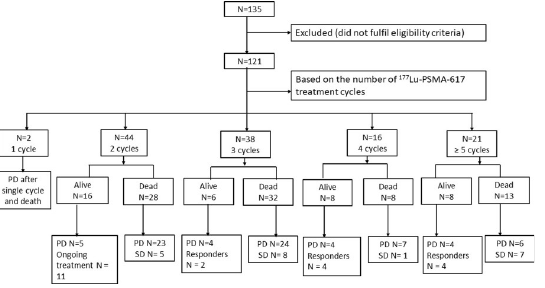
Fig 1. Flow chart depicting the course of treatment and the survival status of the patients categorized according to the number of 177 Lu-PSMA-617 RLT cycles administered. PD: Progressive disease.